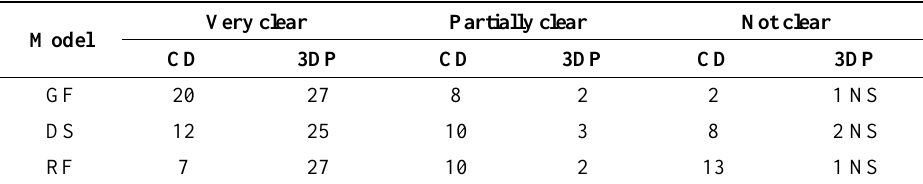
Table 1. Results of the questionnaire (students’ answers).